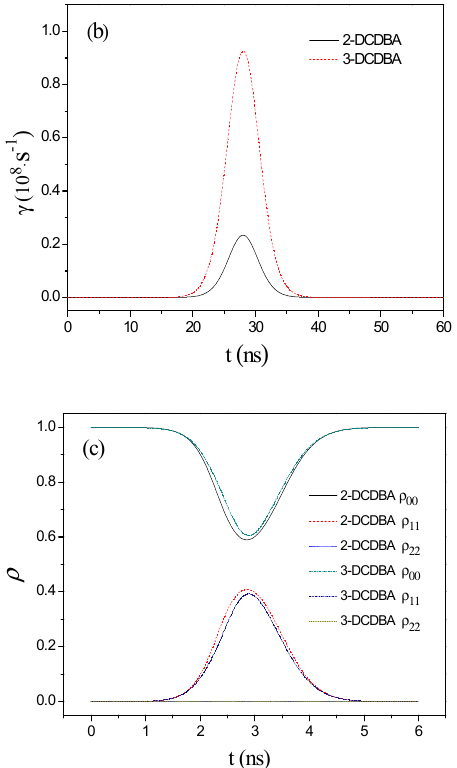
Figure 4. ( a ) The changes in the pulse intensity envelope; ( b ) the pump rate ( I = 6 × 10 8 W/cm 2 , z = 0.24 mm); and ( c ) the particle number density of three levels for 2-DCDBA and 3-DCDBA ( I = 6 × 10 8 W/cm 2 , z = 0.24 mm).